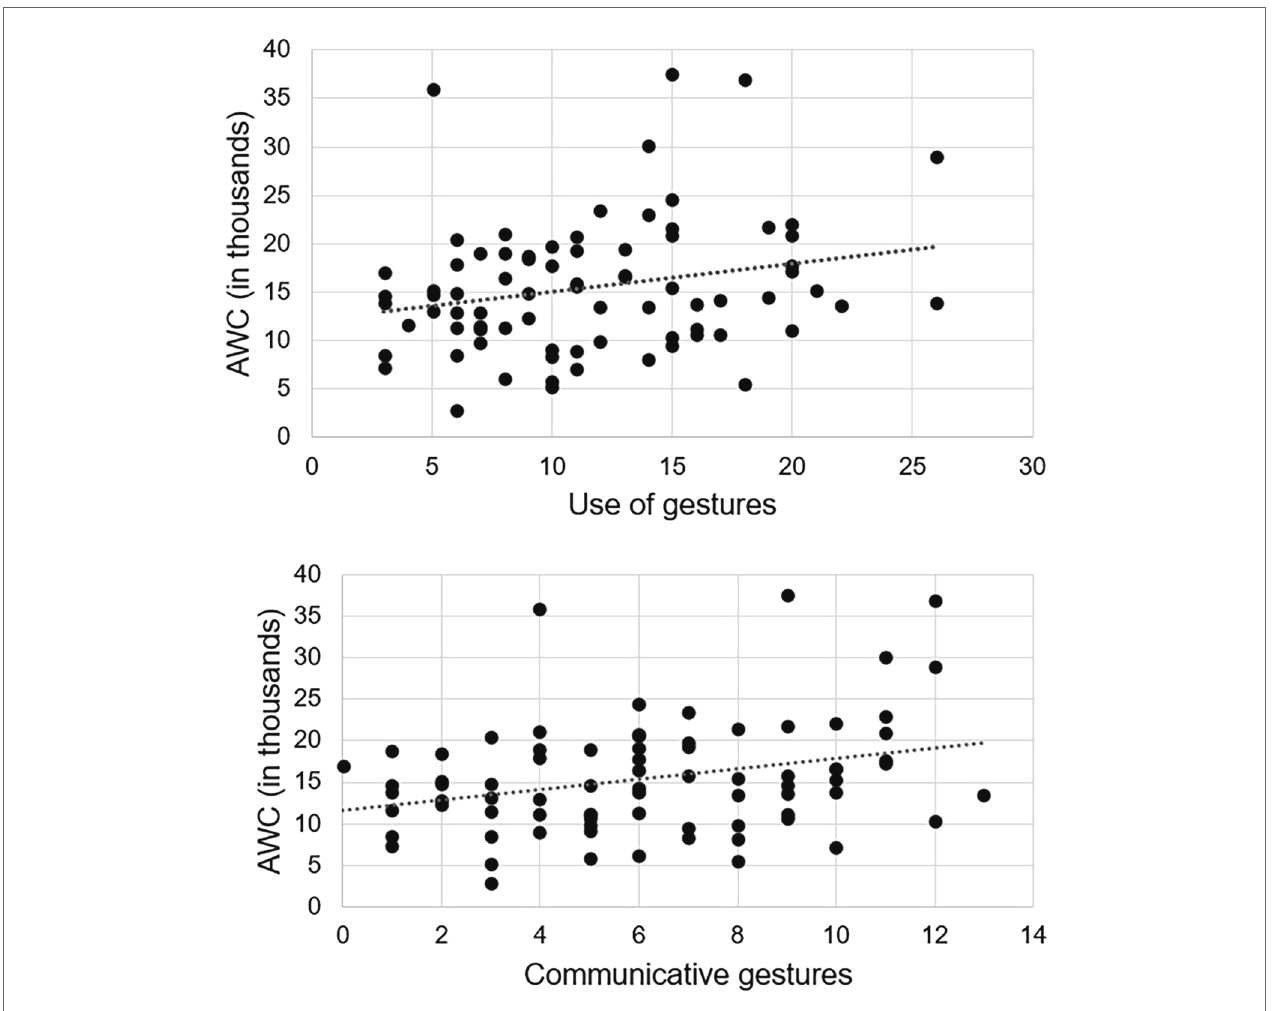
FIGURE 3 | Scatterplots ( n = 78) of the statistically significant associations between the LENA variable adult word count and the SECDI section Use of gestures (upper panel) and Use of gestures subscale Communicative gestures (lower panel)